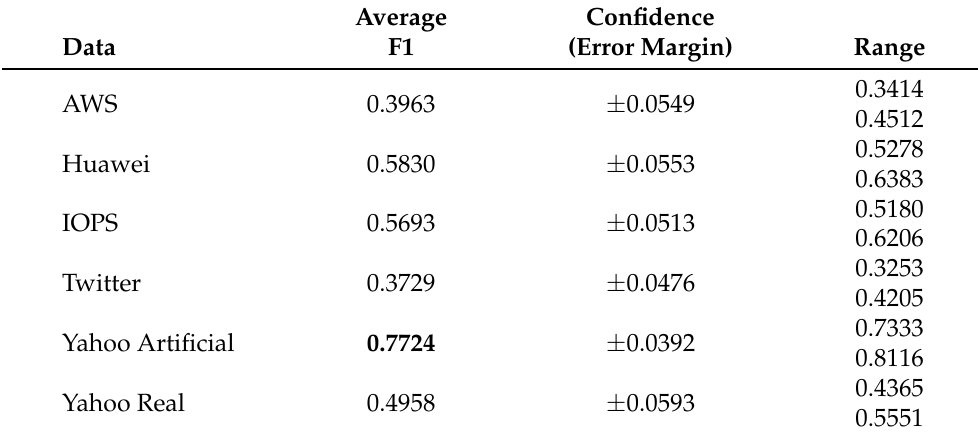
Table 4. Mean F1 by dataset, confidence interval calculated to 95% with population sizes 165, 180, 137, 165, 170, and 165, respectively. Bold font indicates highest average F1